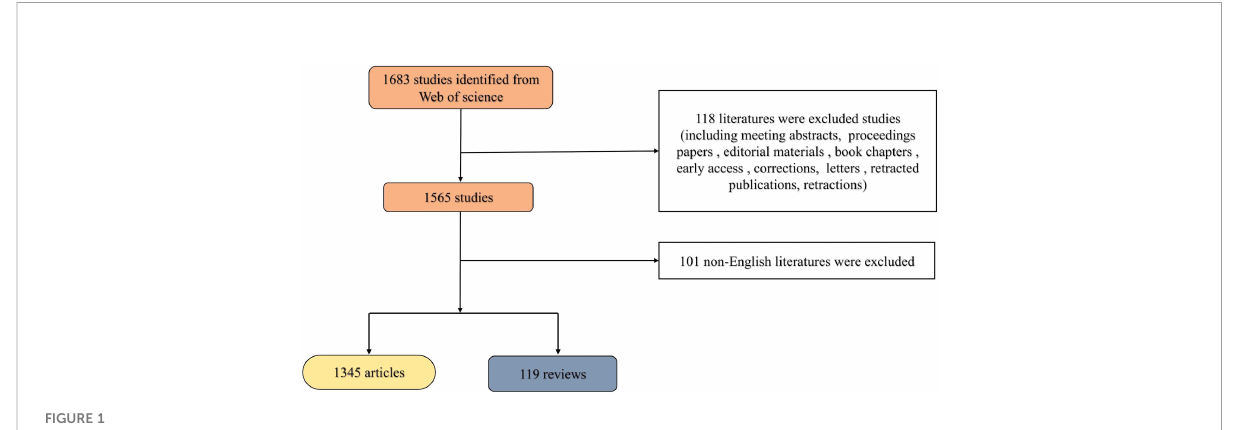
FIGURE 1 Flowchart of the screening